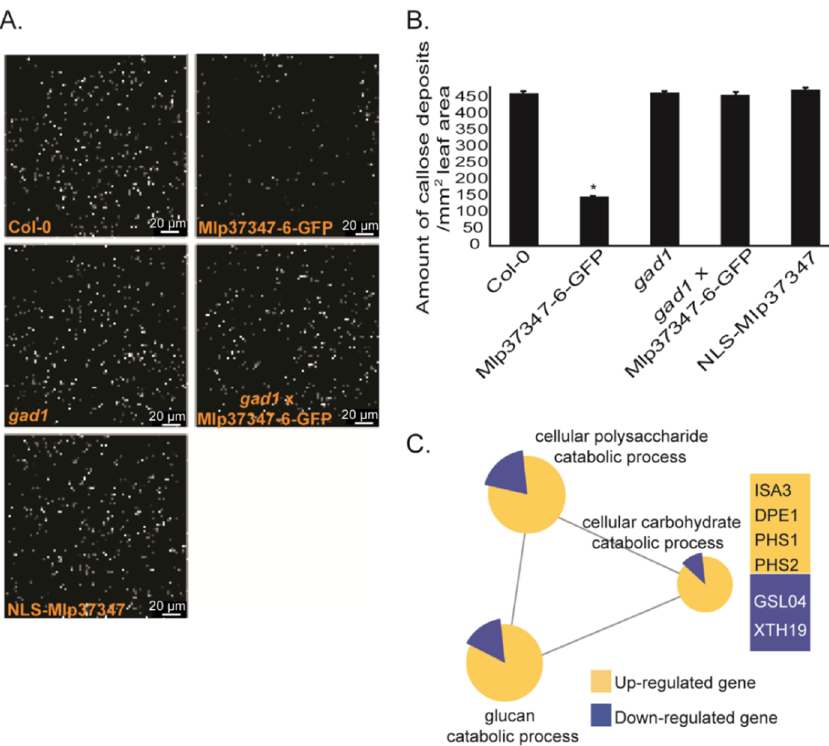
Figure 5. Mlp37347 decreases plasmodesmata callose deposition and affects callose metabolism gene expression. ( A ) Aniline blue staining to visualize the callose levels in A. thaliana transgenic lines Mlp37347-GFP, NLS-Mlp37347-GFP, gad1 , gad1 × Mlp37347-GFP and in Col-0 as a control. Images of callose deposition were taken at 40 × /1.40 magnification, excitation at 488 nm with an emission of 505 to 550 nm using a Leica SP8 confocal microscope. ( B ) Quantification of callose deposition in the different lines. Data represent mean ± SD. The statistical difference from the control Col-0 leaves was determined by Student’s t -test, asterisks indicate statistical significance. ( C ) Transcriptional changes induced by the expression of Mlp37347-6-GFP. Term enrichment analysis was performed on deregulated genes (Q-value ≤ 0.05, fold change ≥ 2) using the Cytoscape software (version 3.1.1).